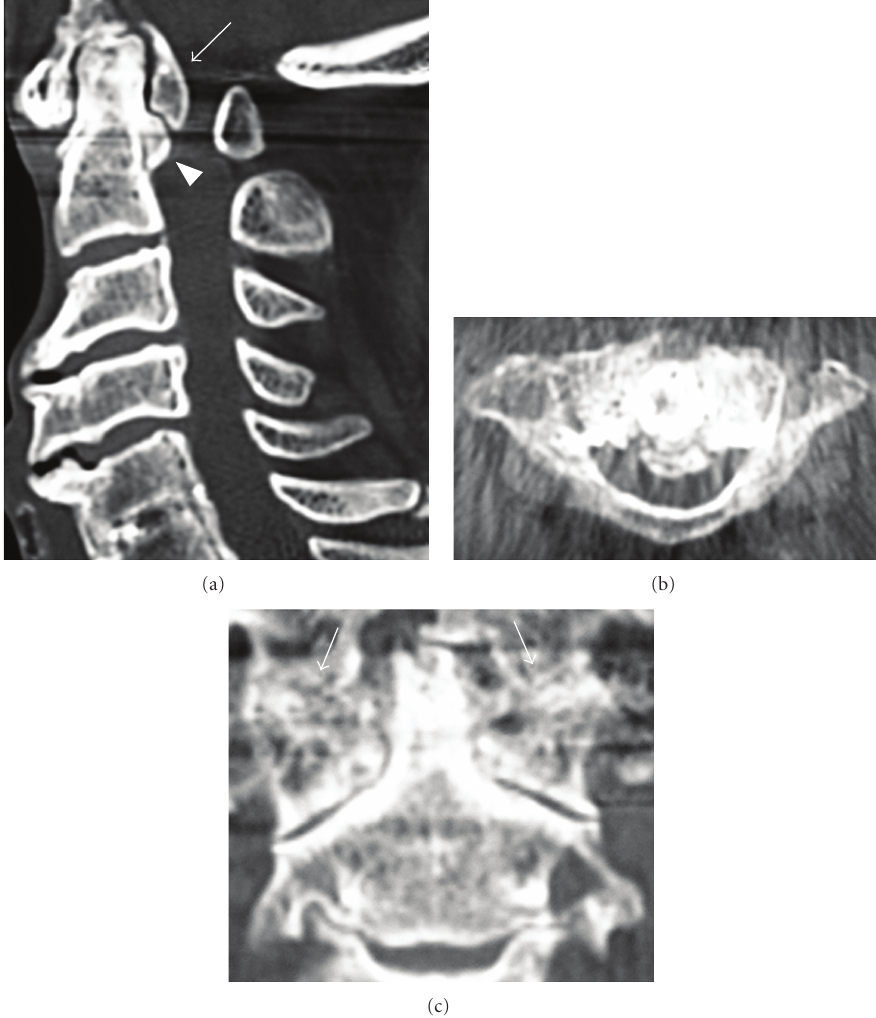
Figure 2: Reconstructed computed tomogram (CT). (a) Sagittal reconstructed CT. Ossified mass behind dens (arrow) and osteophyte continuing from the dens (arrowhead) can be seen. The dens itself is degenerated and hypertrophied. (b) Axial CT. Most of the spinal canal is occupied by ossification of transverse ligament of atlas. (c) Coronal reconstructed CT. The joint space of atlantoaxial joint and the spaces between dens and lateral masses of atlas were narrowed. Coalition of bilateral atlantooccipital joints can be seen